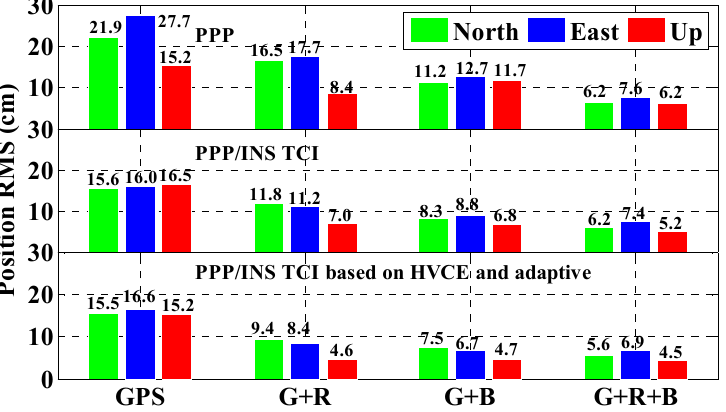
Figure 7. RMS of position offsets from PPP mode ( top ), the PPP/INS tightly coupled integration mode without ( middle ) and with the HVCE and adaptive schemes ( bottom ) using GPS, G + R, G + B, and G + R + B GNSS data. Table 2. Position improvement percentages of the PPP mode, the PPP/INS tightly coupled integration mode without and with the HVCE and adaptive schemes using G + R, G + B, and G + R + B data by comparing with the corresponding GPS based solutions.